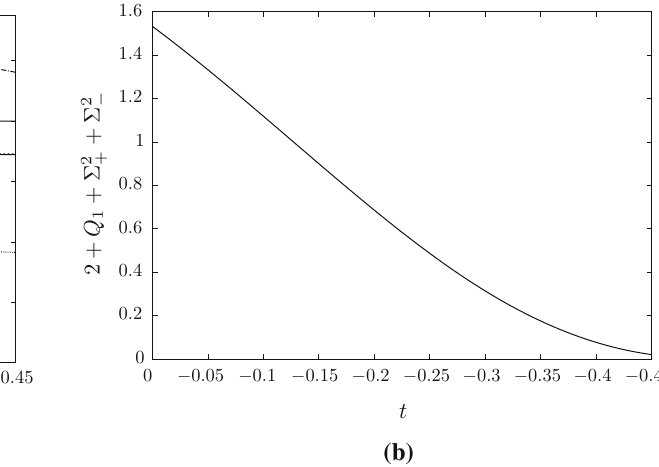
Fig. 2 Backwards time evolution, showing the approach to the sin- gularity. The expansion-normalized shear variables (cid:14) + and (cid:14) − and Q 1 approach constant asymptotic values. We explicitly checked that asymptotically Q 1 < − 4 . 37. In a ) it can be seen that the Ricci scalar